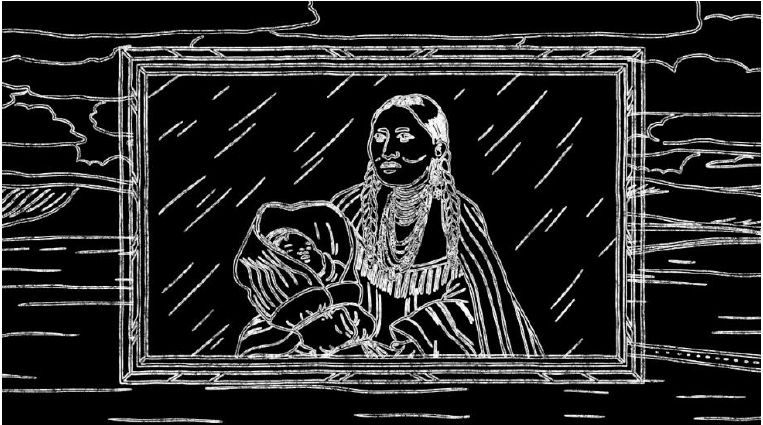
Figure 2. Kerry Tribe, still from The Aphasia Poetry Club (2015), three-channel video with sound, 28:27 min.